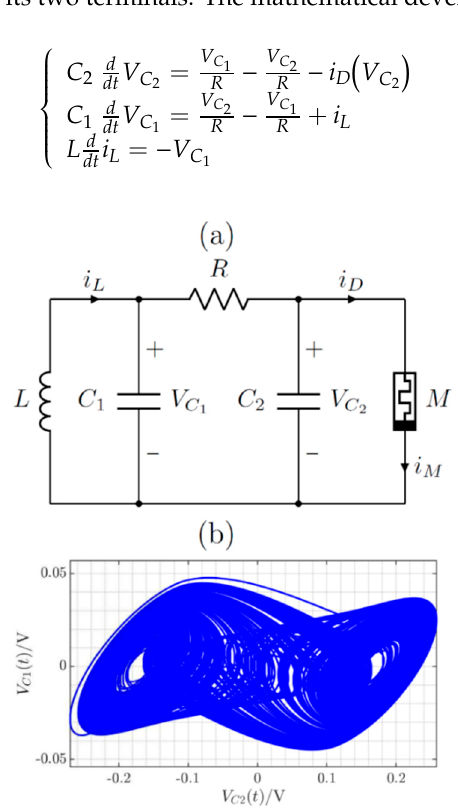
Figure 2. Chaotic circuit implemented with a Chua diode: ( a ) electrical circuit; ( b ) diagram of Vc 2 ( t ) versus Vc 1 ( t ) of the chaotic attractor.